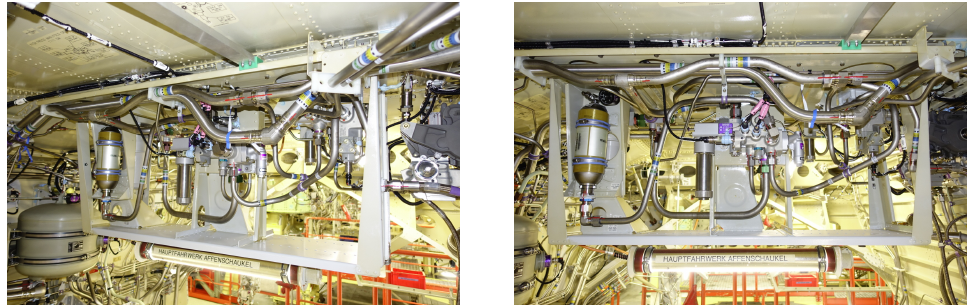
Figure 2. Airbus A320 series solution mounting rack (©2022 AIRBUS Operations